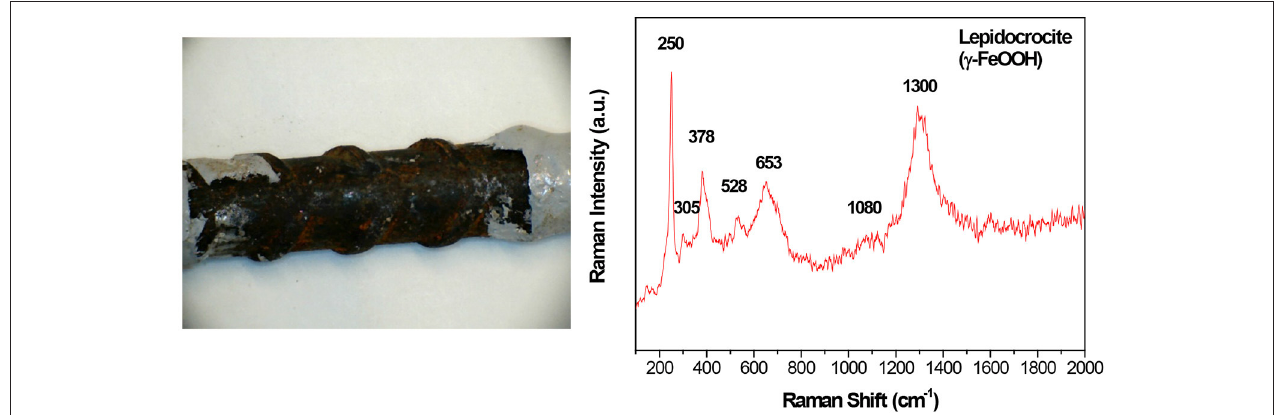
FIGURE 3 | Photograph of the surface of the original steel, and Raman spectrum of the rust layer detected on its surface.